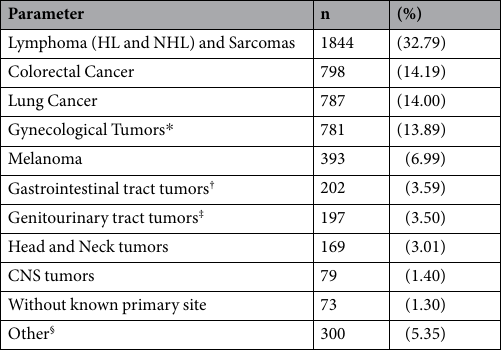
Table 1. Clinical diagnoses of patients undergoing PET/CT (n = 5623). CNS = central nervous system; HL = Hodgkin lymphoma; NHL = non-Hodgkin lymphoma. * Breast, ovarian, uterine, and endometrial. † Pancreas, liver, esophagus, stomach, and biliary tree. ‡ Kidneys, bladder, ureter, prostate, and testes. § Neuroendocrine, cardiac, thyroid, other.